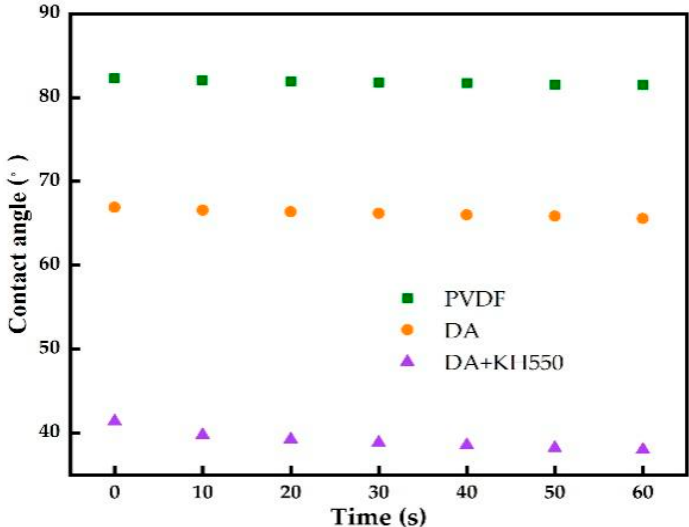
Figure 4. Comparison of the water contact angle of pristine PVDF and coated membranes.